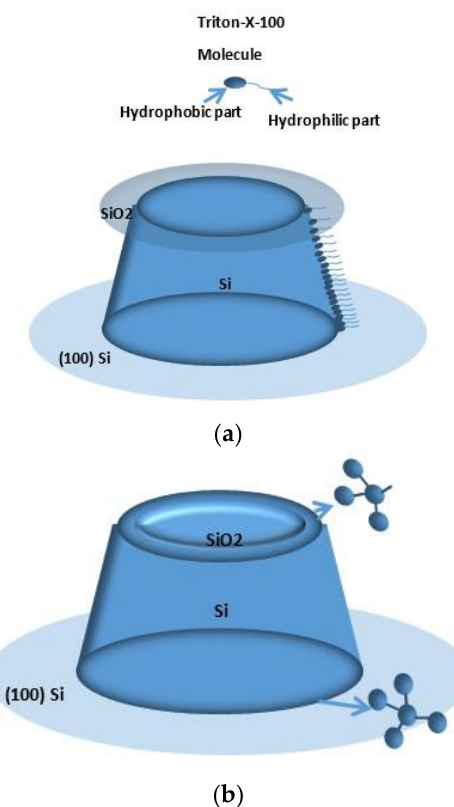
Figure 13. Model explaining the wet etching on the silicon surface: ( a ) additive’s gradient absorption model on sidewall; ( b ) dangling bond model along circular convex edge.